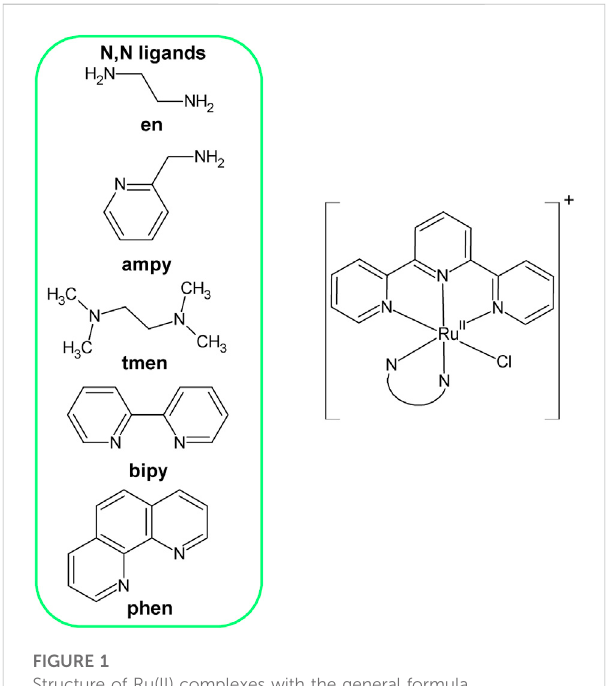
FIGURE 1 Structure of Ru(II) complexes with the general formula [Ru II (terpy)(N ∧ N)Cl] +